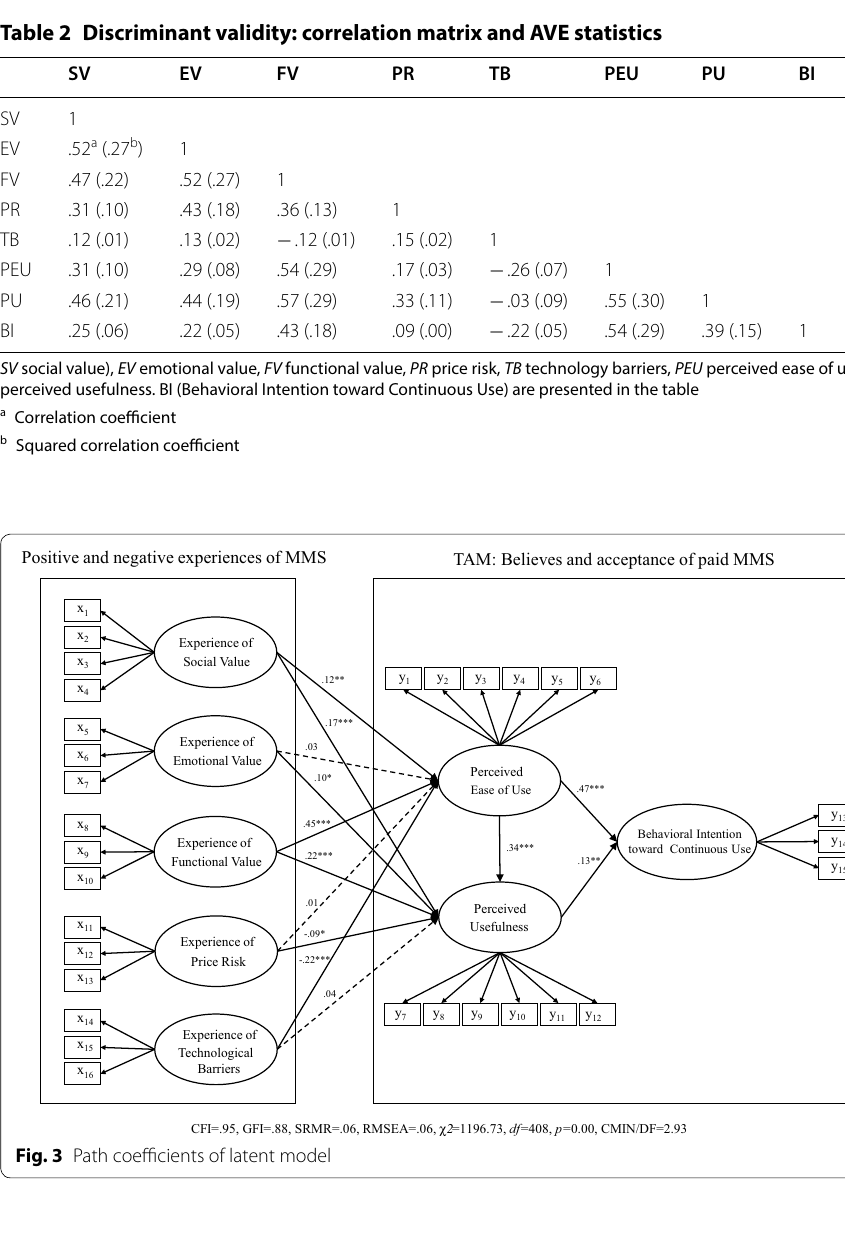
Table 2 Discriminant validity: correlation matrix and AVE statistics